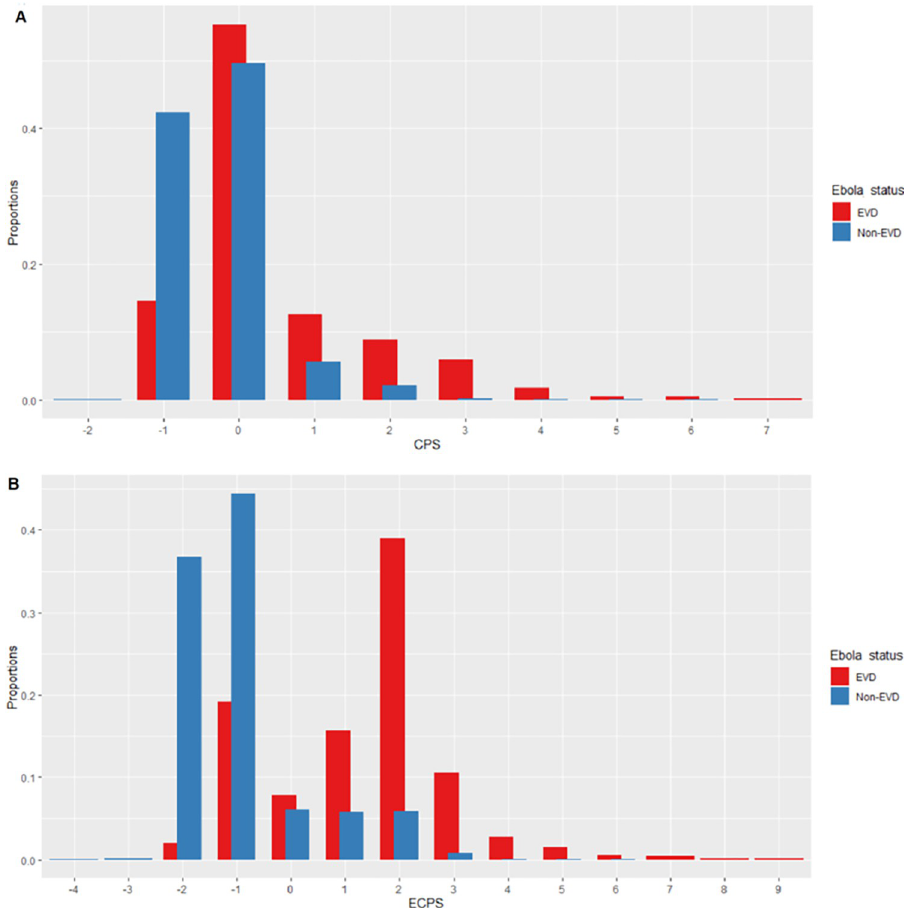
Fig 2. Barplots depicting the distribution of the clinical prediction score and extended clinical prediction score in EVD and Non-EVD groups.